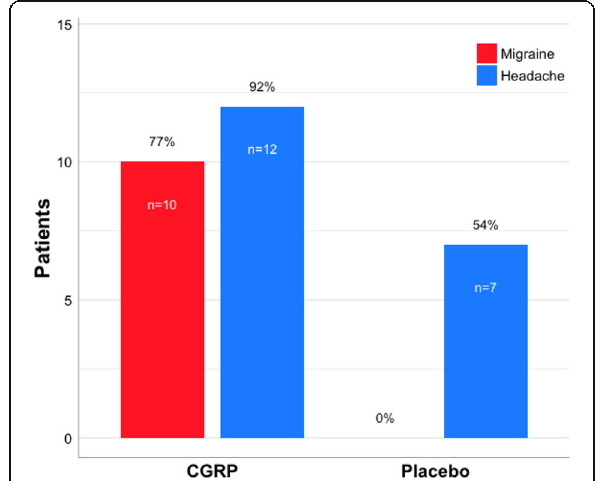
Fig. 4 Proportion of patients who developed migraine-like attacks and headache after CGRP and placebo. More patients developed migraine-like attacks after CGRP ( n = 10), compared to placebo